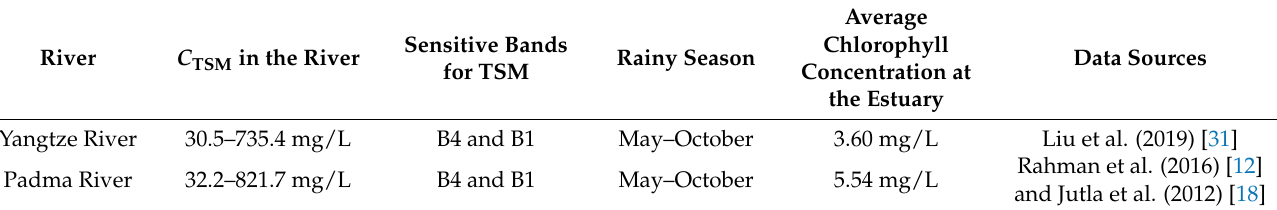
Table 1. Comparison of the characteristics of the Yangtze and Padma Rivers. Average Sensitive Bands River C TSM in the River Rainy Season for TSM Concentration at the Estuary